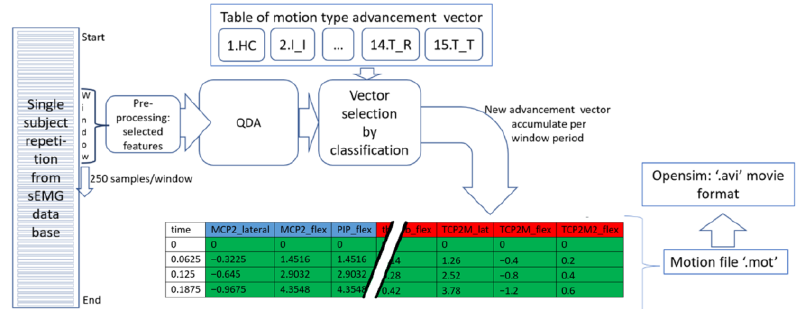
Figure 11. Cycle from classification to generation of the movement file for Opensim.